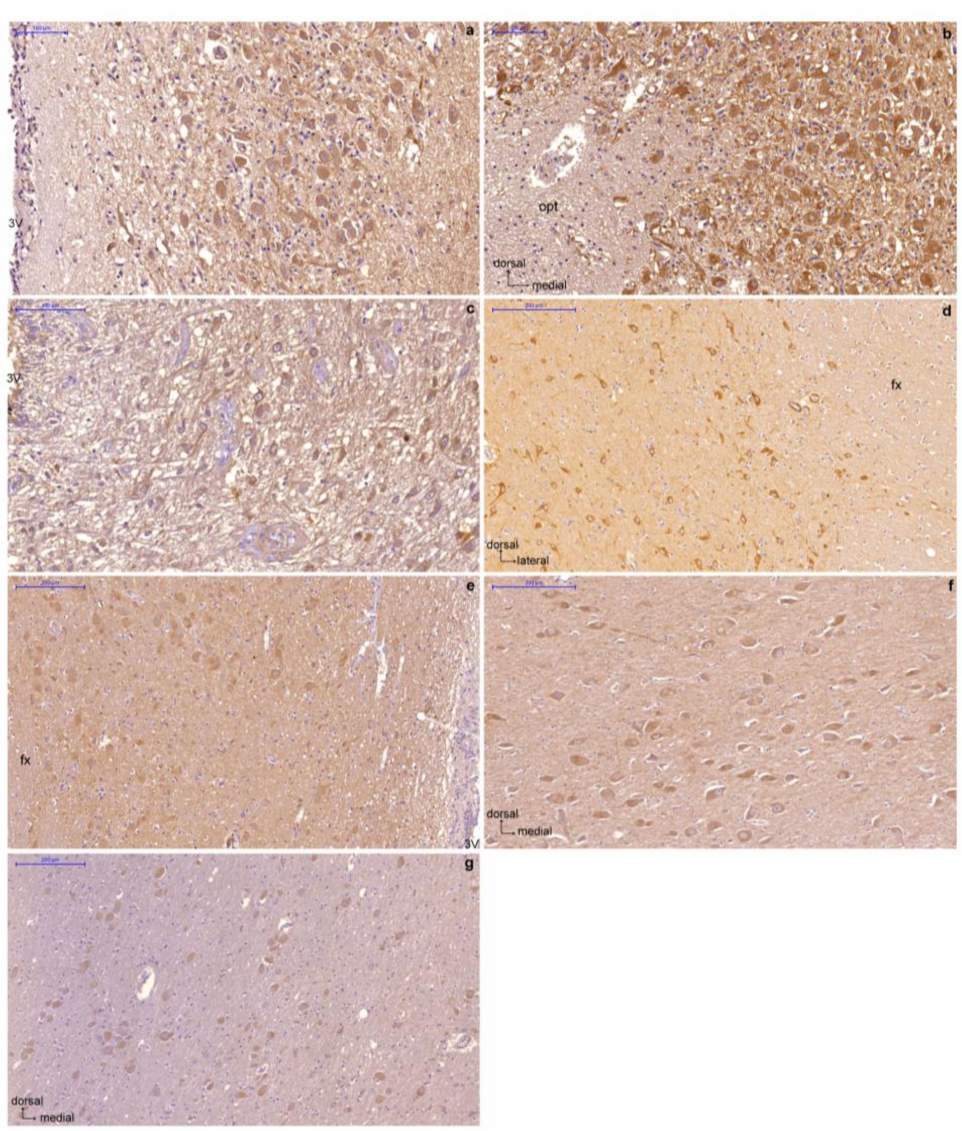
Figure 1. Representative sections of human hypothalamus showing GLP-1R immunoexpression in neurons of the paraventricular nucleus ( a ), supraoptic nucleus ( b ), infundibular nucleus ( c ), lateral hypothalamic area ( d ), dorsomedial nucleus ( e ), basal nucleus ( f ), diagonal band ( g ). The 3V, third ventricle; fx, fornix; opt, optic tract. Scale bars indicate 100 µ m ( a – c ) and 200 µ m ( d – g